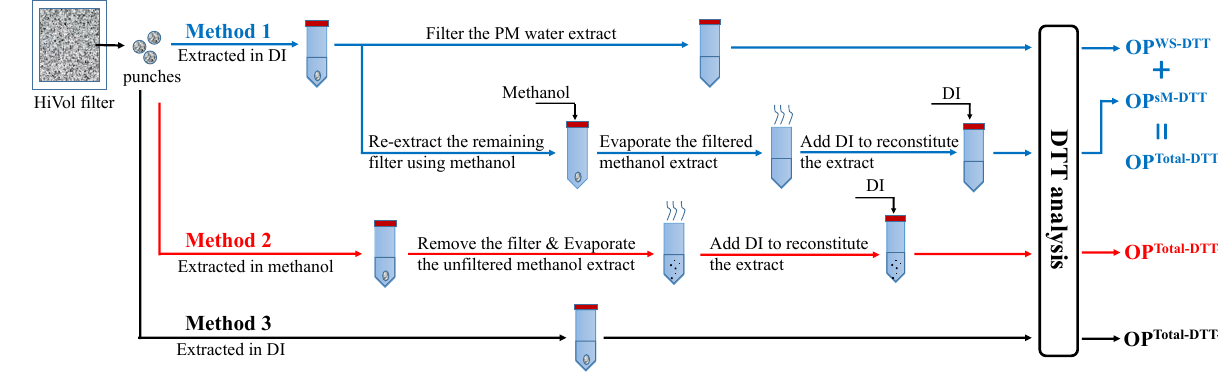
Figure 1. Analytical scheme for three sample extraction methods to determine total OP with the DTT assay (OP Total-DTT